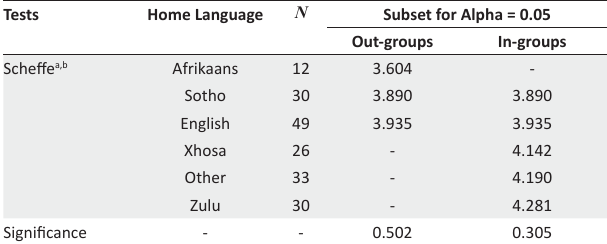
TABLE 7: Homogeneous Subsets for out-group across language